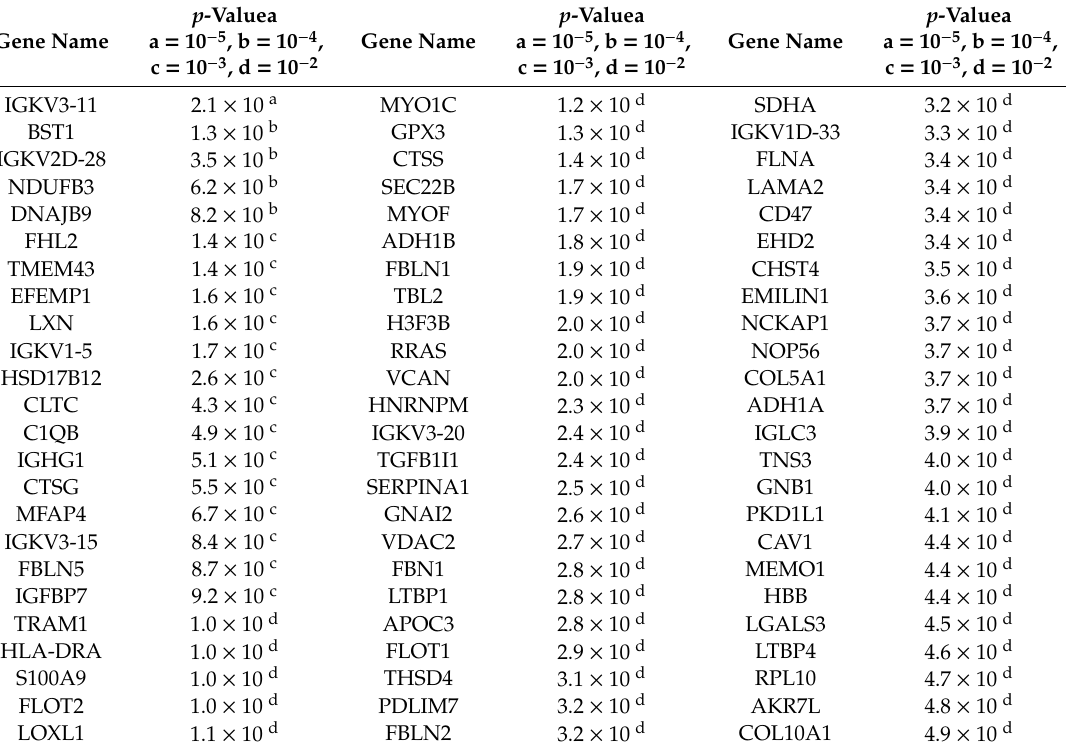
Table 2. Significantly abundant proteins in decellularized cirrhotic sca ff